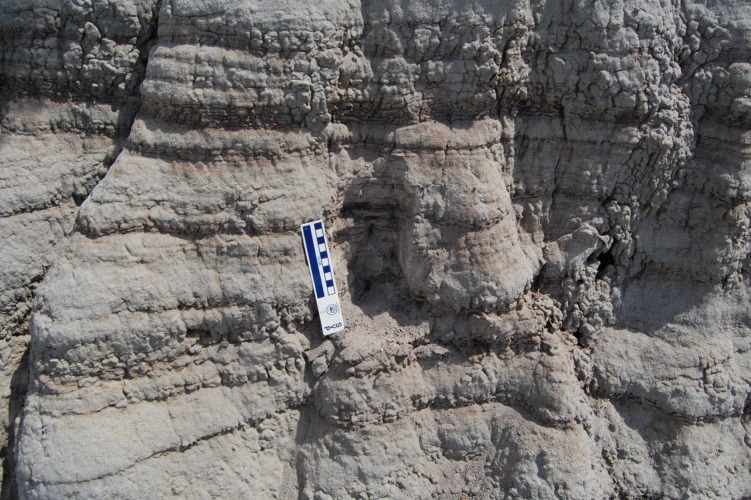
Mudstone from 693 m elevation after sampling.